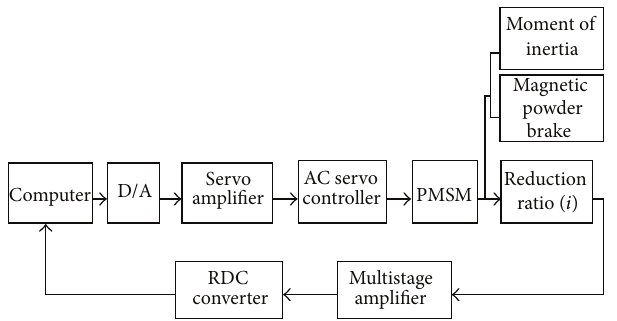
Figure 1: The structure diagram of AC servo